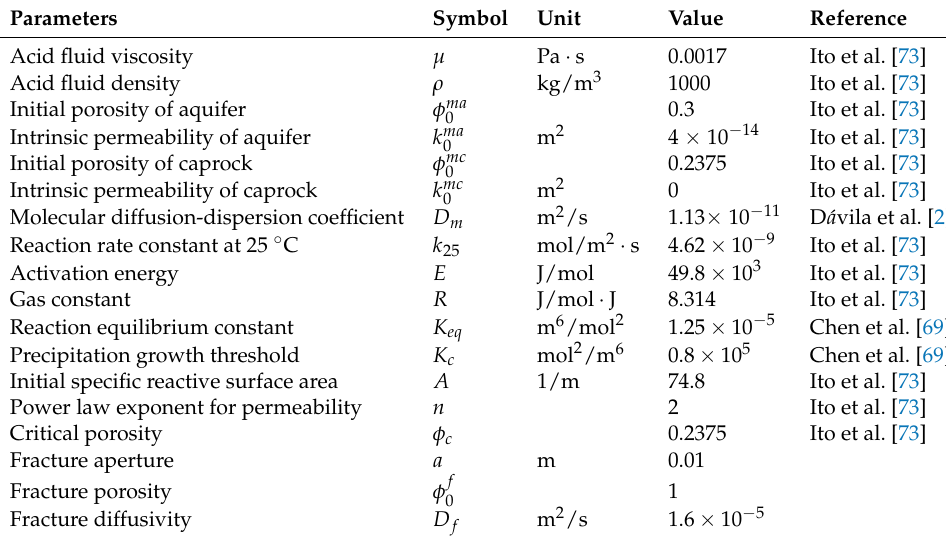
Figure 3. A 3D model for simulation the process of remedying CO 2 leakage by grouting. Table 1. Simulation parameters for chemical precipitation